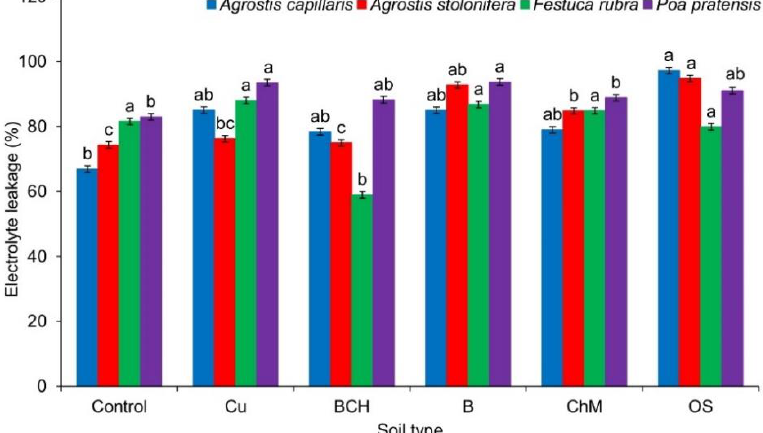
Figure 5. Percentage of electrolyte leakage through cell membranes of grass seedlings germinated on various modifications of soil contaminated with copper; Cu—copper soil, copper soil with sorbents: BCH—biochar, B—bentonite, ChM—chicken manure, OS—organo-zeolitic substrate; mean values ( n = 5; ± SD) marked with different letters (within each species) differ significantly according to Duncan’s test with p ≤